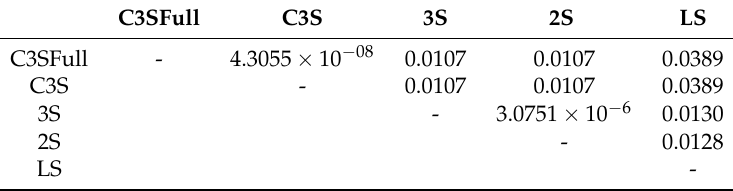
Table 8. Pairwise squared norm distance between the estimates for the airfoil self-noise data